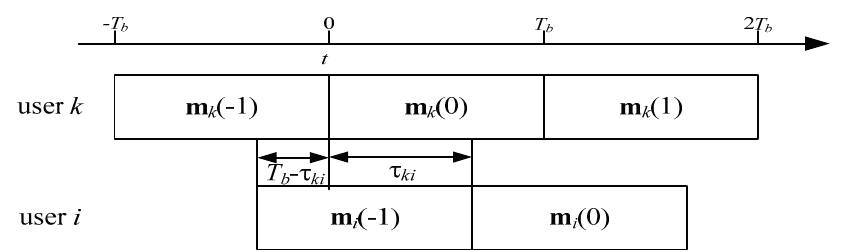
Figure 3. The propagation delay between two